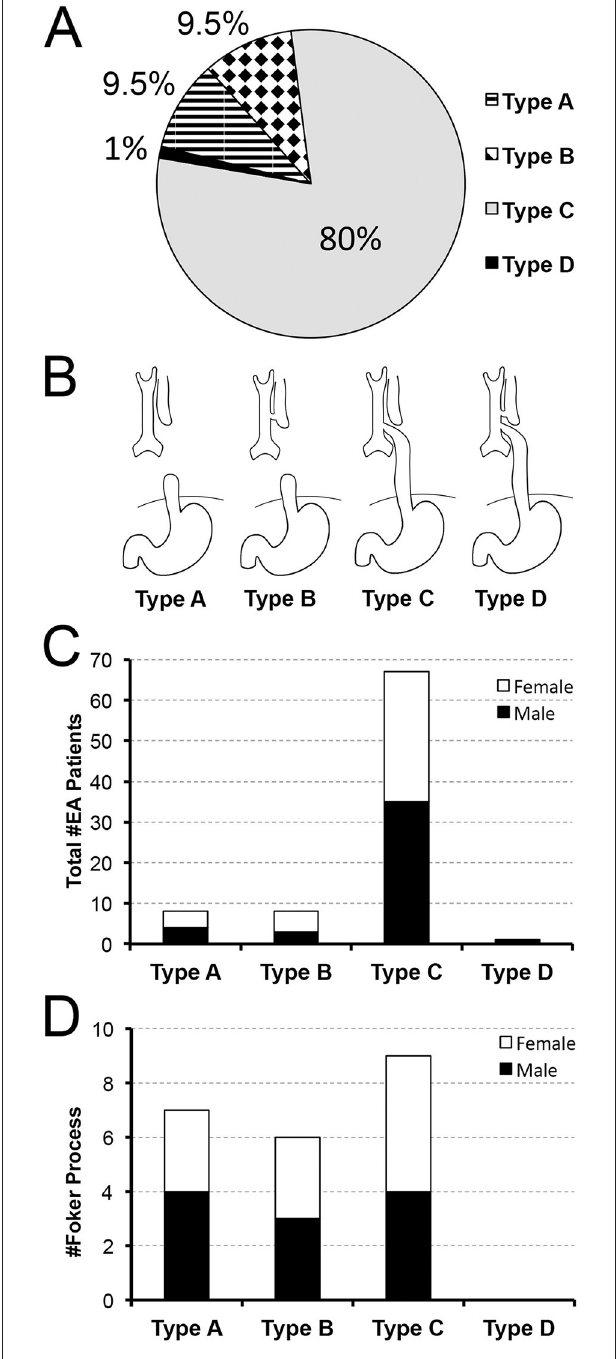
FIGURE 1 | Retrospective Analysis of Incidence of Primary Esophageal Atresia Repair at a Single Institution. Data was retrospectively collected from 2009–2020 ( n = 84). Pie chart in (A) summarizes the percent (%) incidence of esophageal atresia (EA) by anatomical classification that is schematically illustrated in (B) . According to our retrospective data analysis, anatomical type C of EA is the most frequently encountered. Graph in (C) also illustrates nearly equal sex distribution per anatomical type with females found in 50% in type A , 62.5% in type B , and 48% in type C . Graph in (D) summarizes the incidence of long-gap EA patients ( n = 22) that underwent Foker process (5–8). Incidence of long-gap EA follows the trend per anatomical type and sex, similar to the cohort as a whole (see Results for more